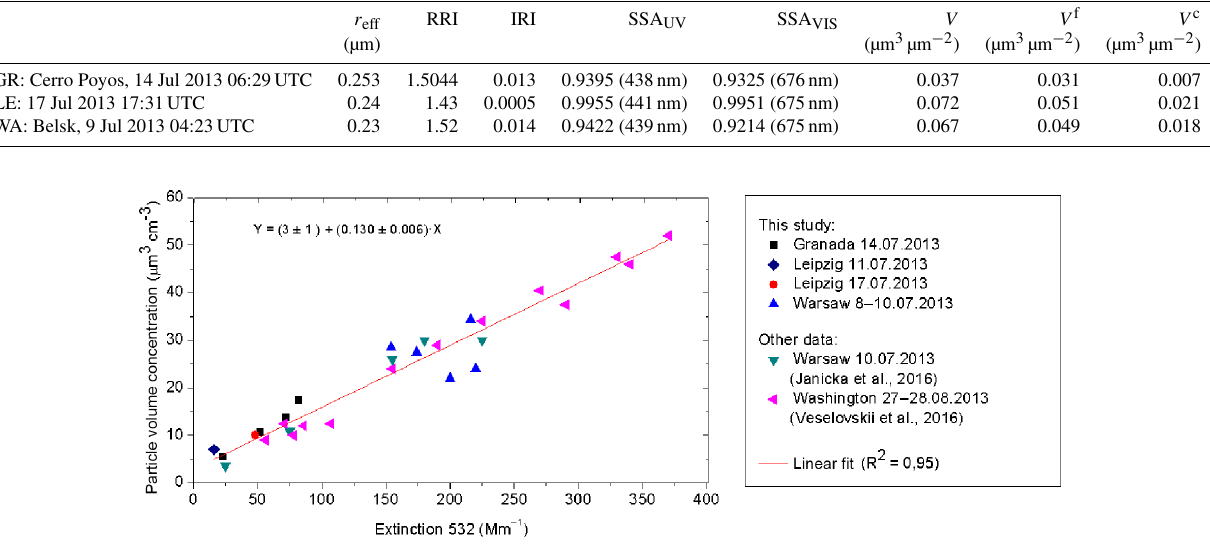
Figure 10. Scatter plot of the particle volume concentration as a function of the extinction coefficient at 532nm. The red line represents the linear